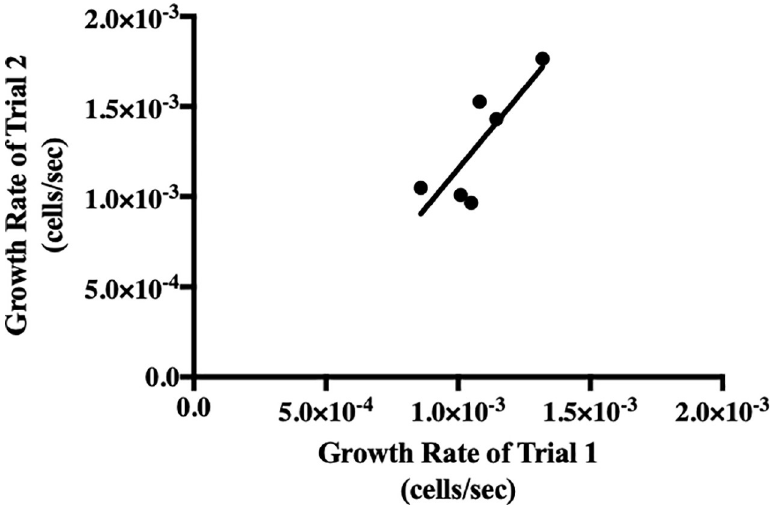
Fig 8. Comparison of growth rate measurements via two independent trials of S . cerevisiae cycloheximide gradients on the μ PAD assay. The relationship between the growth rate (cells/sec) measured during Trial 1 (x-axis) and Trial 2 (y-axis) can be modelled by the equation, y = 1.77x + .0006151. This model accounts for 67.22% of the variability in the data per R 2